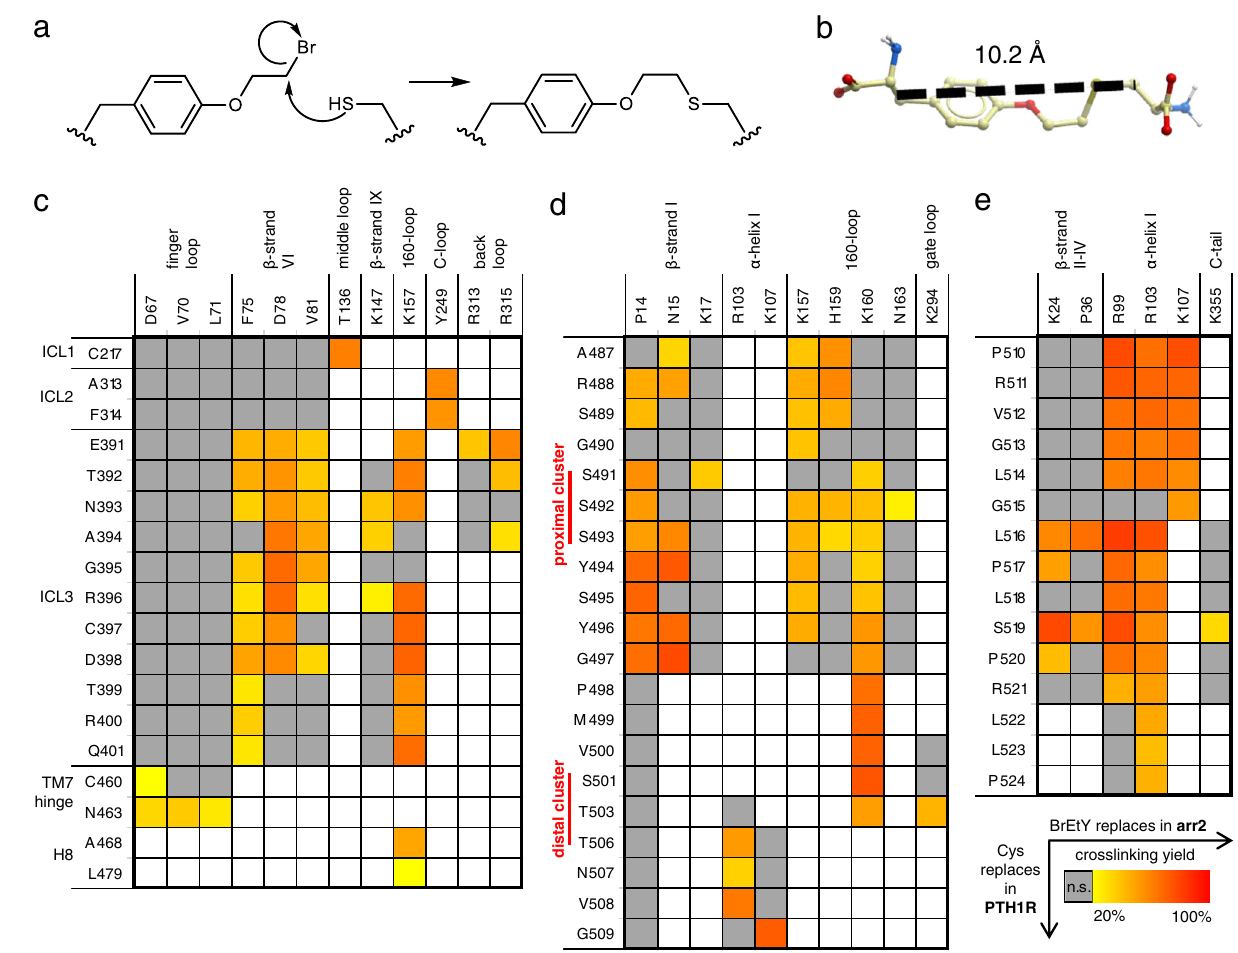
Fig. 2 | Identi fi cation of PTH1R-arr2 intermolecular pairs of proximal residues via thiol trapping. a Nucleophilic substitution reaction between the Cys thiol and thehaloalkanemoietyofBrEtY.Thereactionoccursonlywhenthetwomoietiesare close to each other, and yields a stable thioether. b The length of BrEtY crosslink (10.2Å) was estimated as the maximal distance between C β atoms in the BrEtY- cysteine adduct based on the extensive conformational sampling of the adduct